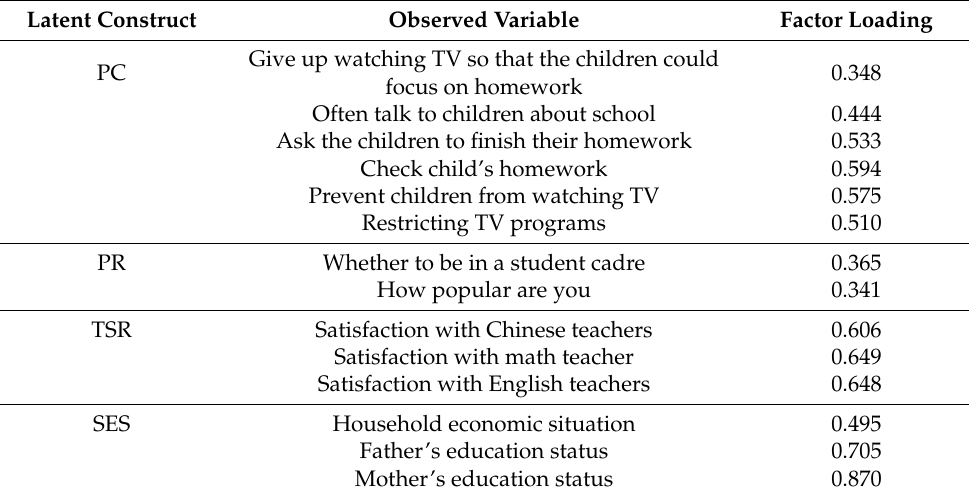
Table 2. Standardized factor loadings of the observed variables on the latent